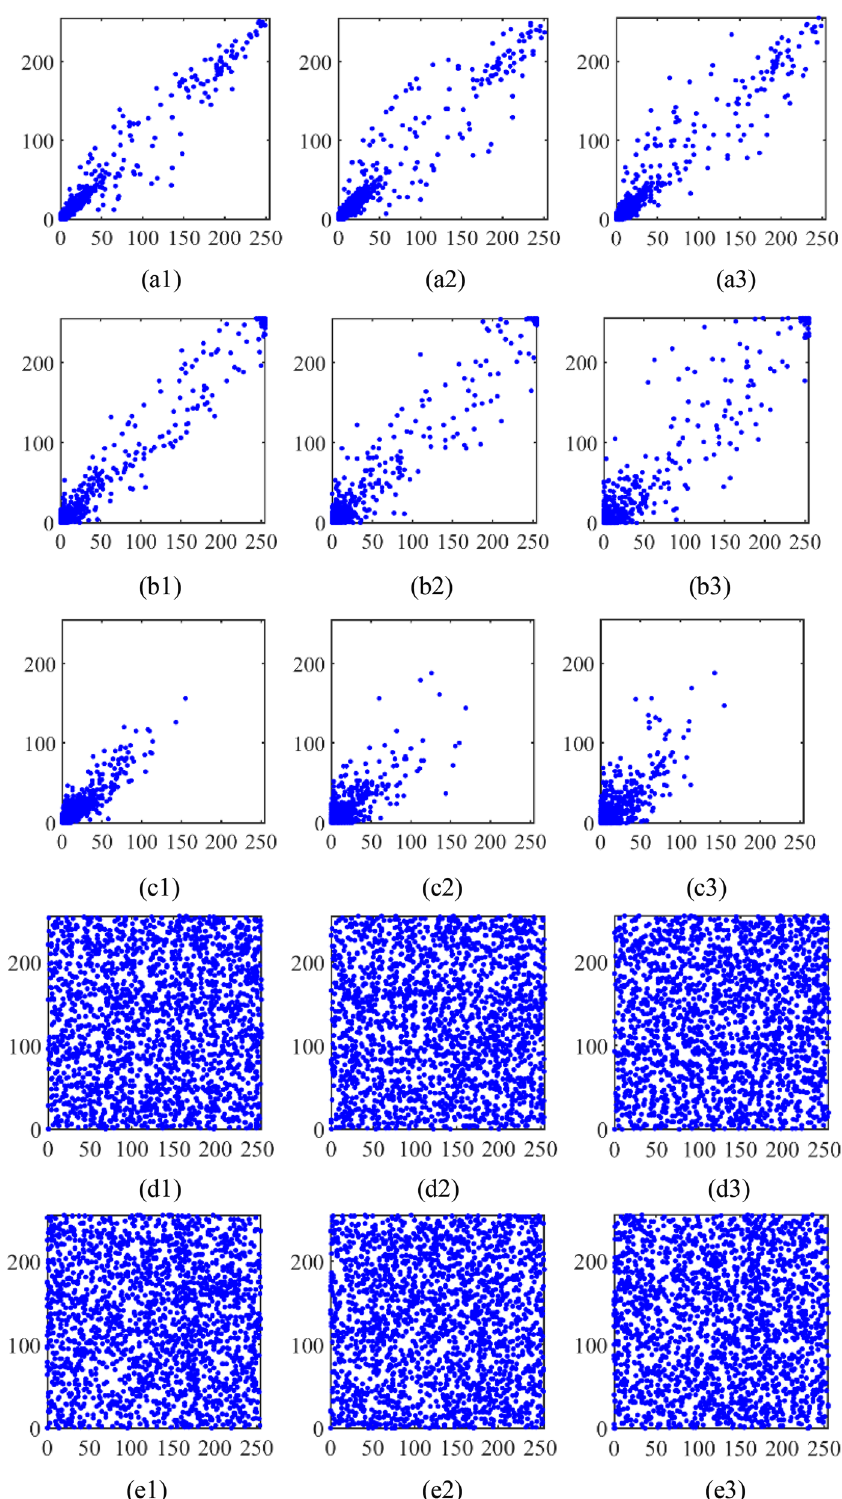
Figure 8. ( a1 – a3 ) The adjacent pixel distributions of plaintext in the horizontal, vertical and diagonal directions; ( b1 – b3 ) the adjacent pixel distributions of cosine hologram in the horizontal, vertical and diagonal directions; ( c1 – c3 ) the adjacent pixel distributions of sine hologram in the horizontal, vertical and diagonal directions; ( d1 – d3 ) the adjacent pixel distributions of c x in the horizontal, vertical and diagonal directions; ( e1 – e3 ) the adjacent pixel distributions of of c y in the horizontal, vertical and diagonal